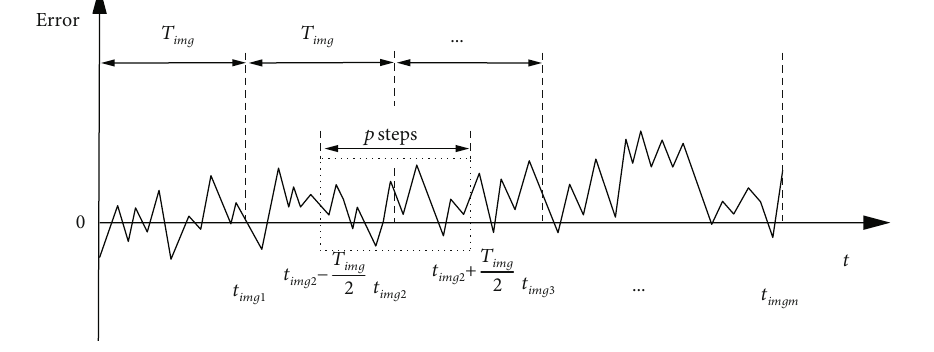
Figure 1: Imaging time interval and imaging instants.